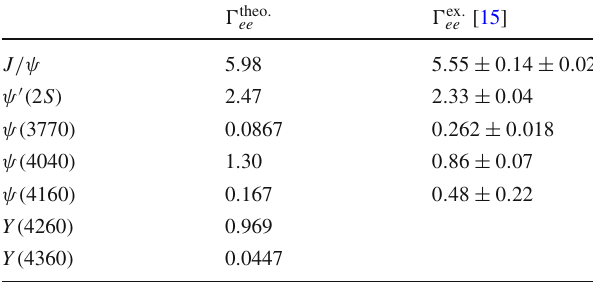
Table 5 Di-leptonic decay widths, i.e., (cid:8) ee in the unit of keV